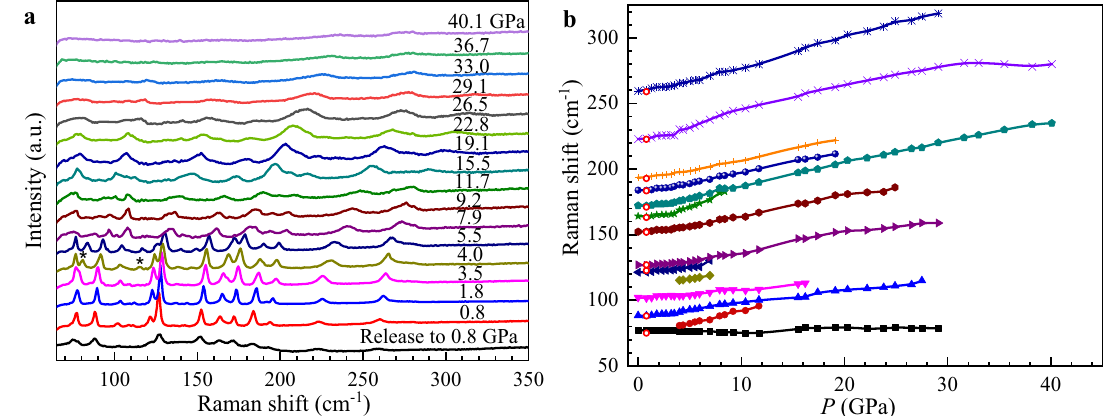
Fig. 4 Raman spectroscopy measurement under pressure. a Raman spectra with pressures up to 40.1 GPa, including the spectrum with pressure decrease to 0.8 GPa. The stars represent the new modes which appeared as pressure approached to 3.5 GPa. b Pressure dependence of Raman shifts. The open red circles are Raman shifts when pressure releases to 0.8